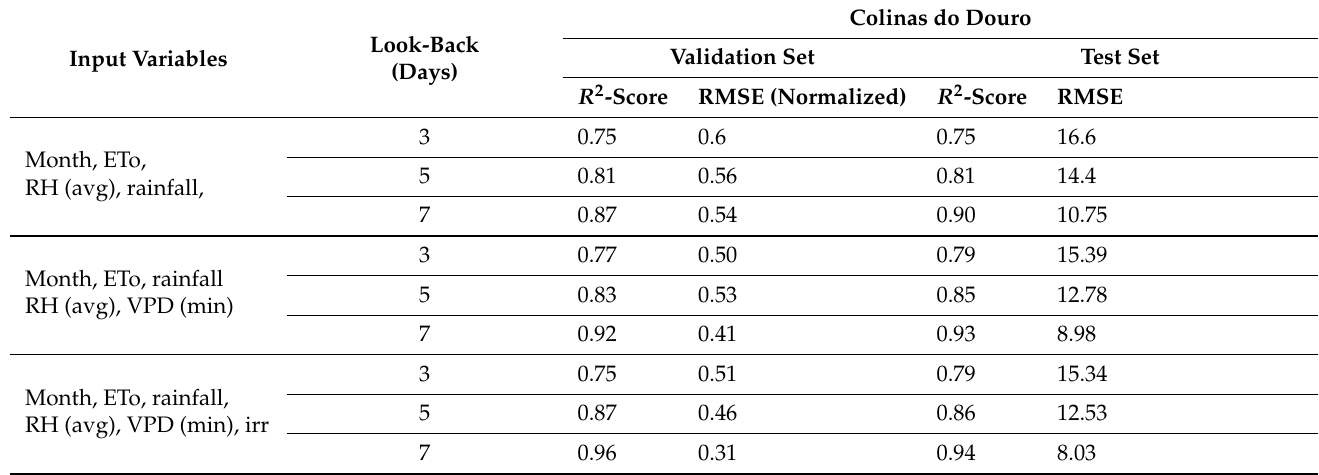
Table 5. The performance of the BiLSTM model to predict the FTSW one day ahead with different input